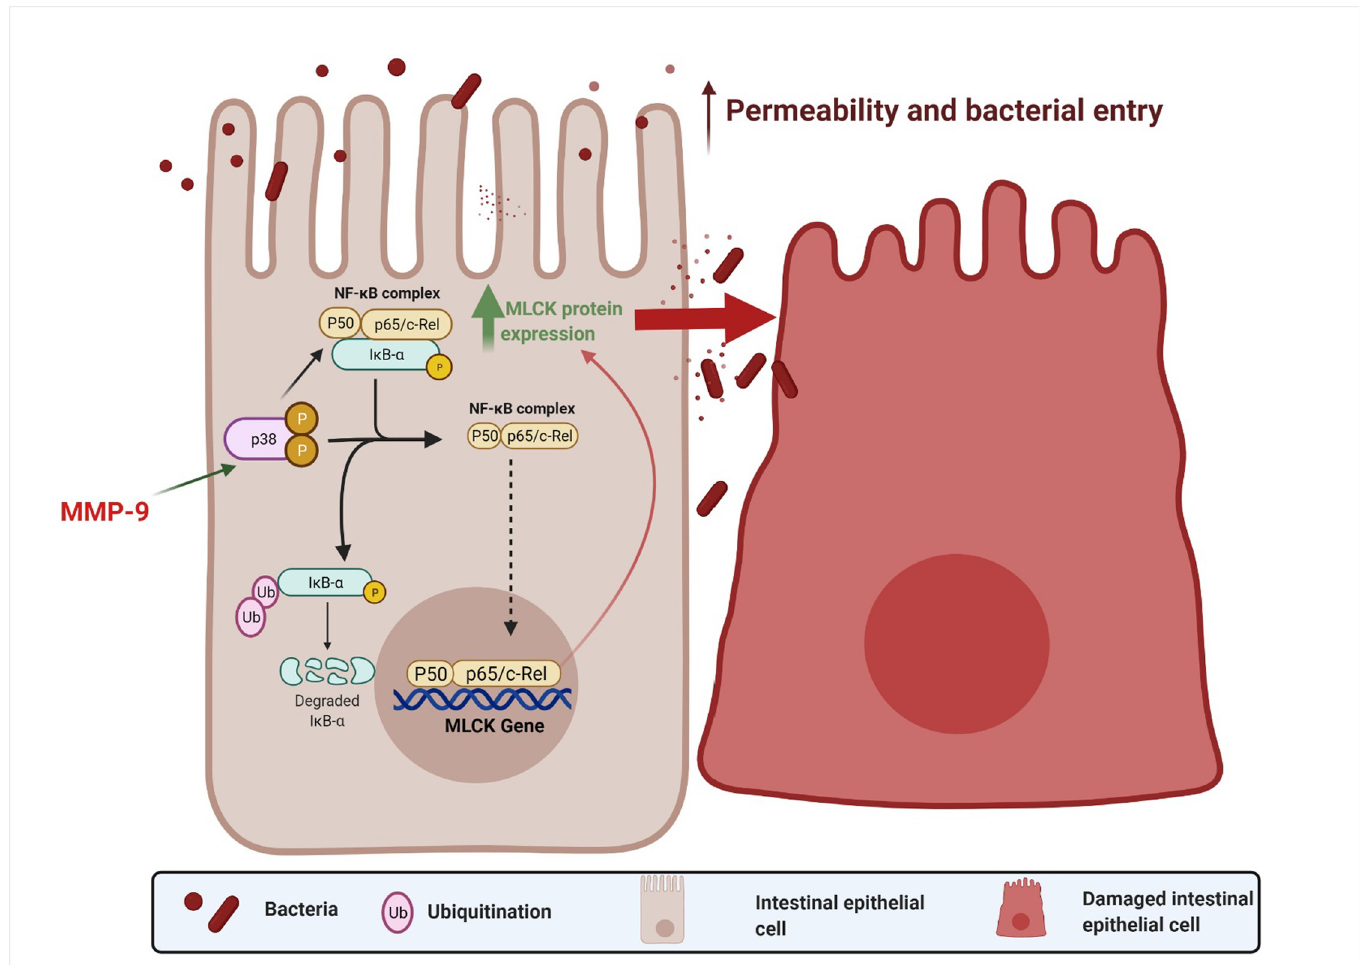
Fig 5. Schematic diagram of intracellular mechanism involved in MMP-9 regulation of Caco-2 TJ barrier function.